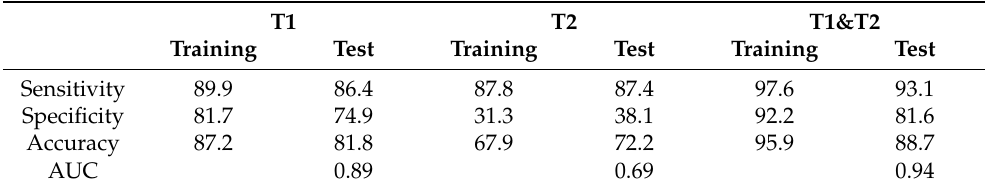
Table 5. Assessment of the predictive performance of the predictive model for training and testing data with T1-weighted MR image (T1), T2-weighted MR image (T2), and the combination of T1- and T2-weighted MR images (T1&T2).